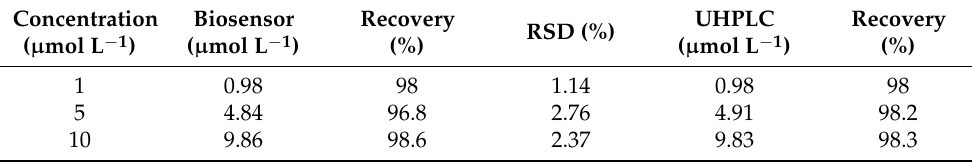
Table 3. Rutin tablet sample determinations using UHPLC and electrochemical methods. Concentration